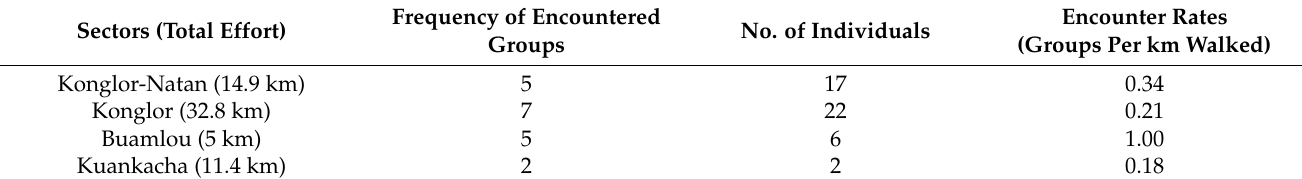
Figure 3. Sighting locations of the Laotian langur using Landsat 8 images. These images were taken from 22 January 2021 with bands 5–4–3 combination. Table 3. Laotian langur encountered on trails walked in each sector. In this table, we include both the directly observed groups and those recorded by vocalizations during our surveys. For these latter groups, it was impossible to determine the size, sex or age of their